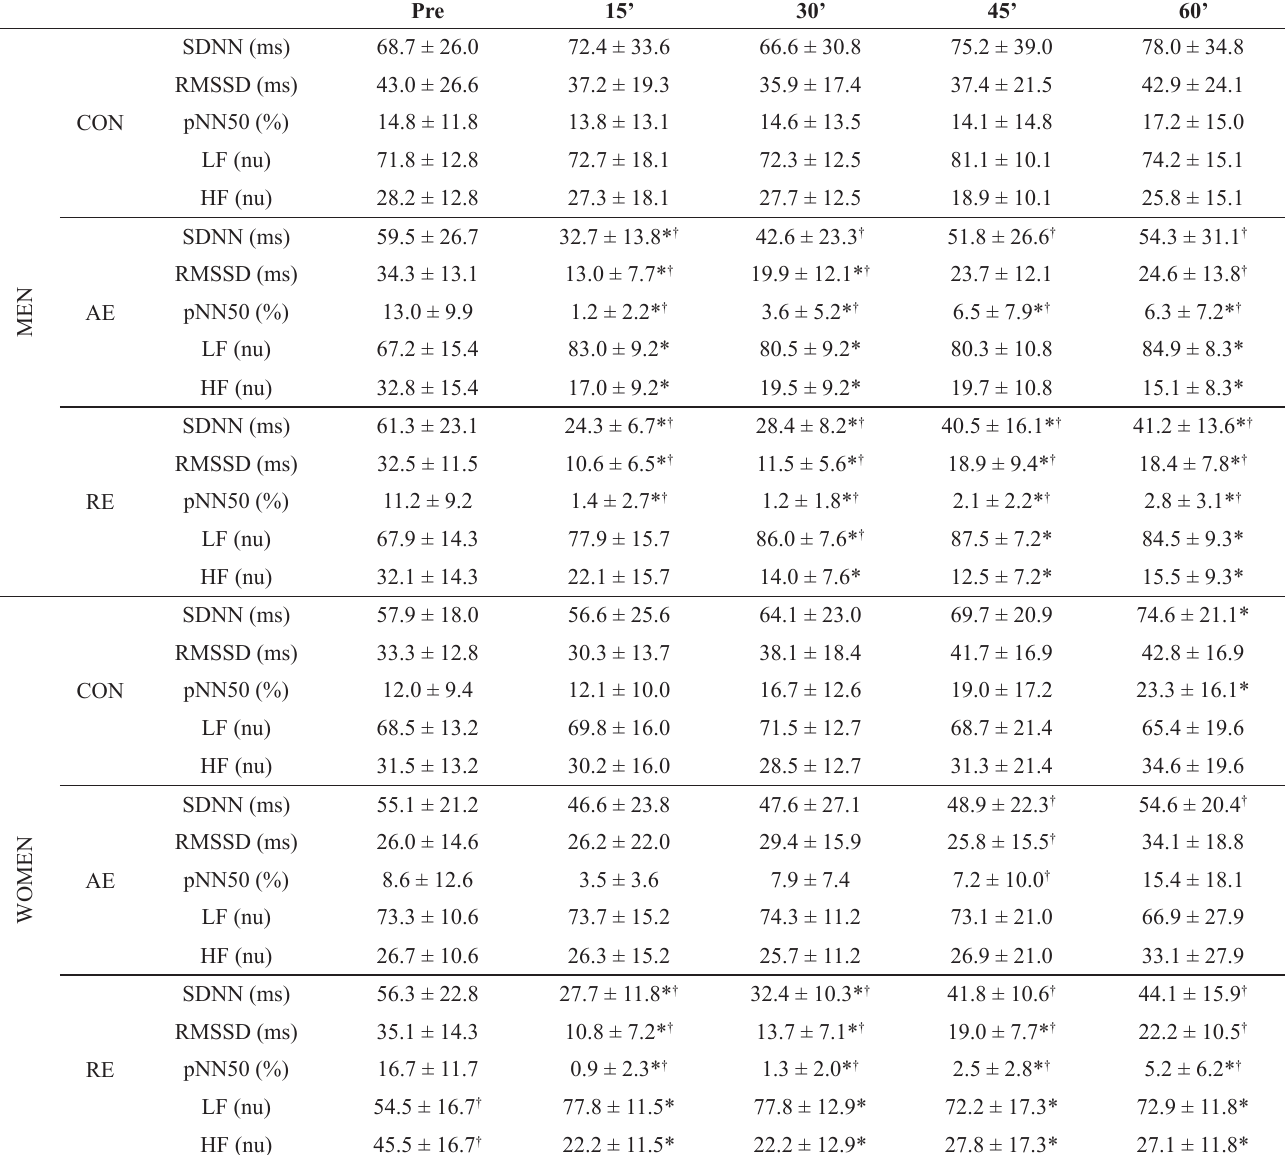
Table 3. Heart rate variability measured at pre-exercise and during recovery in laboratory Pre